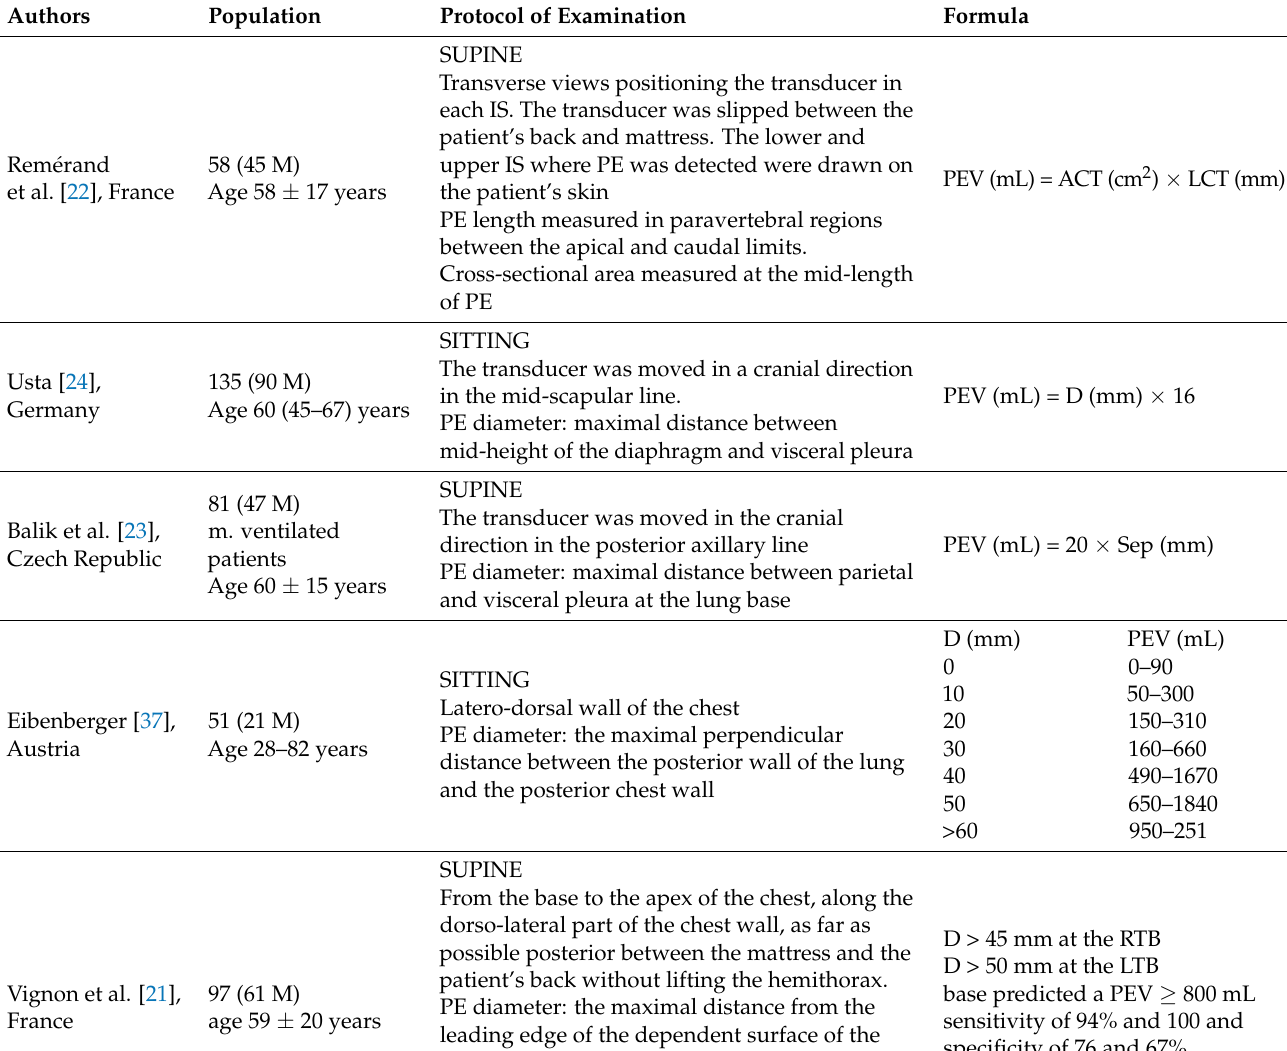
Table 2. Major studies proposing formula for pleural effusion